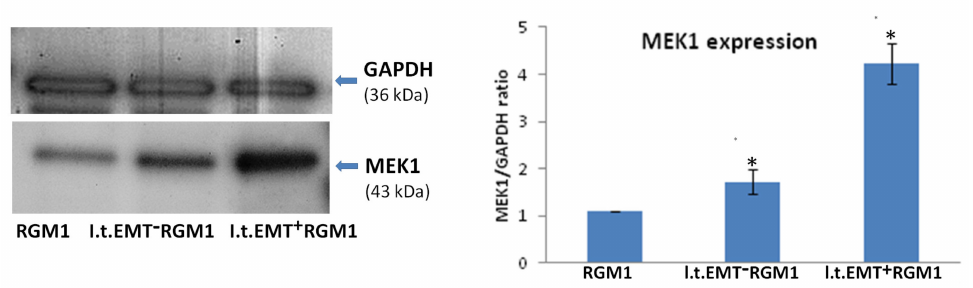
Figure 4. Hp -AGF secretome induces potentially pro-proliferative phenotype of l.t.EMT + RGM1 cells. Western blot analysis of MEK1 protein expression in total cellular proteins isolated from l.t.EMT − RGM1 cells, l.t.EMT + RGM1 cells, and original RGM1 cells and semi-quantitative densitometry analysis of the ratio of selected proteins over GAPDH showing the increased expression of MEK1 protein. The 10 µ g of total cellular proteins were loaded per each lane. Results are mean ± SEM of three independent experimental repeats. Asterisk indicates a significant change ( p < 0.05) as compared to the control RGM1